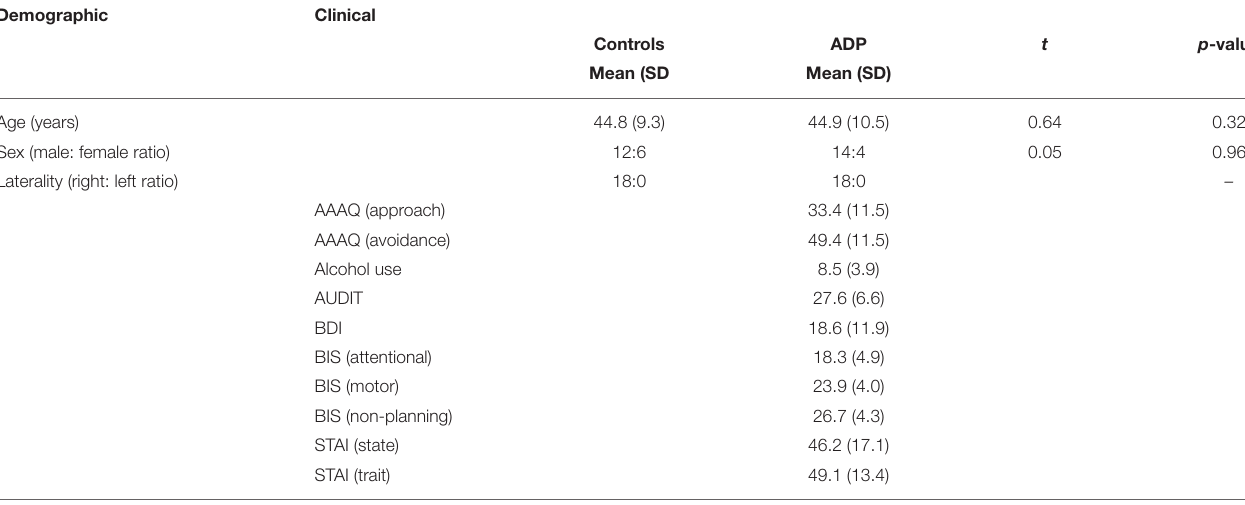
TABLE 1 | Demographic and clinical characteristics at D0 of controls ( n = 18) and alcohol-dependent patients (ADP) ( n = 18). Demographic